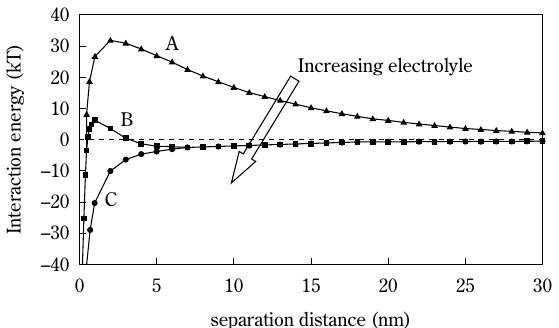
Fig.1 Energy as a function of separation distance for the interaction of two spherical particles across an aqueous electrolyte medium. Particles have a radius of 100 nm and a Hamaker constant of 1 × 10 − 20 J. The three data sets correspond to conditions of increas- ing electrolyte. Data set A: ψ = 22 mV and 1/ κ = 10 nm. Data set B: ψ = 22 mV and 1/ κ = 1.5 nm. Data set C: ψ = 0